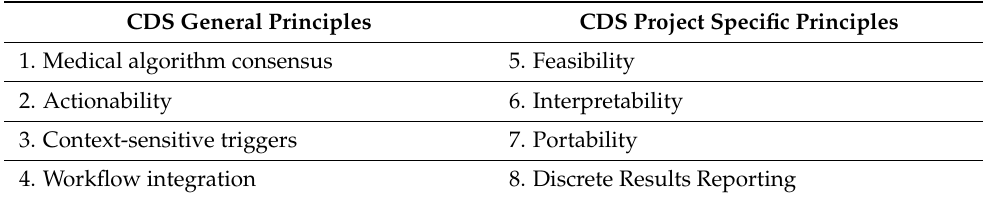
Table 1. Guiding principles for the CDS